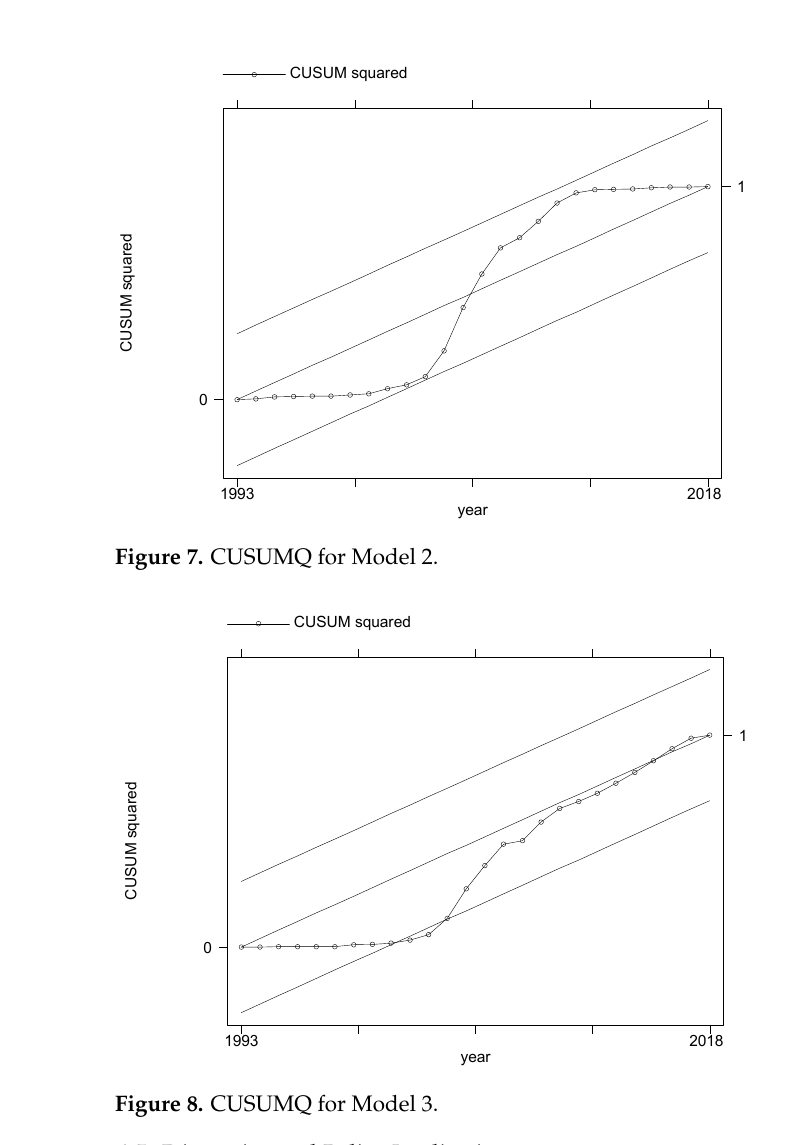
Figure 6. CUSUMQ for Model 1.